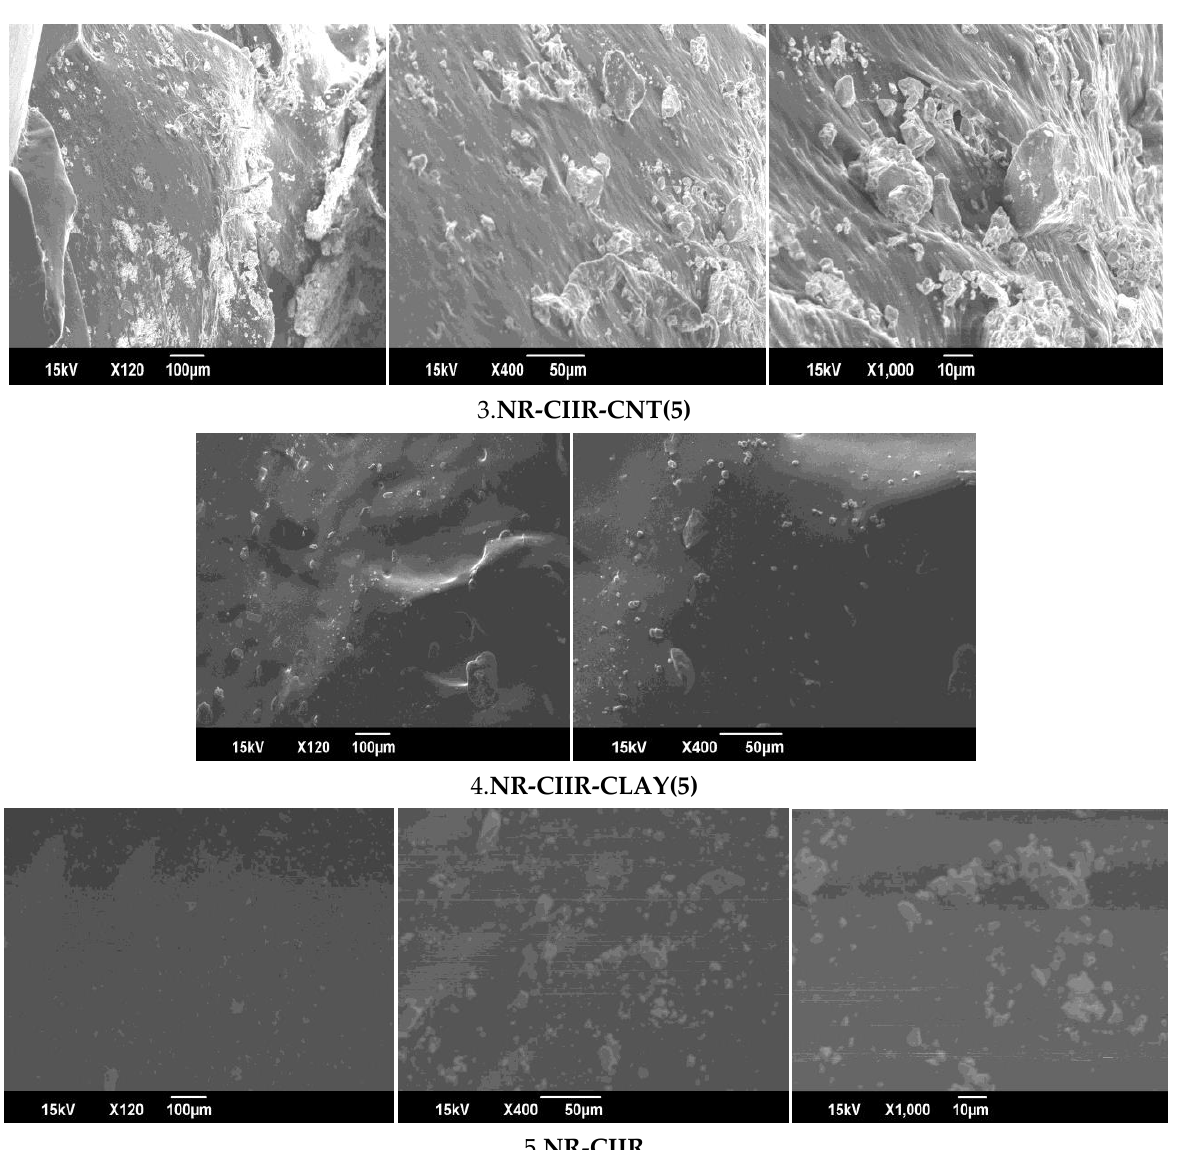
Figure 3. The SEM image of NR-CIIR blend rubber composite of different fillers.